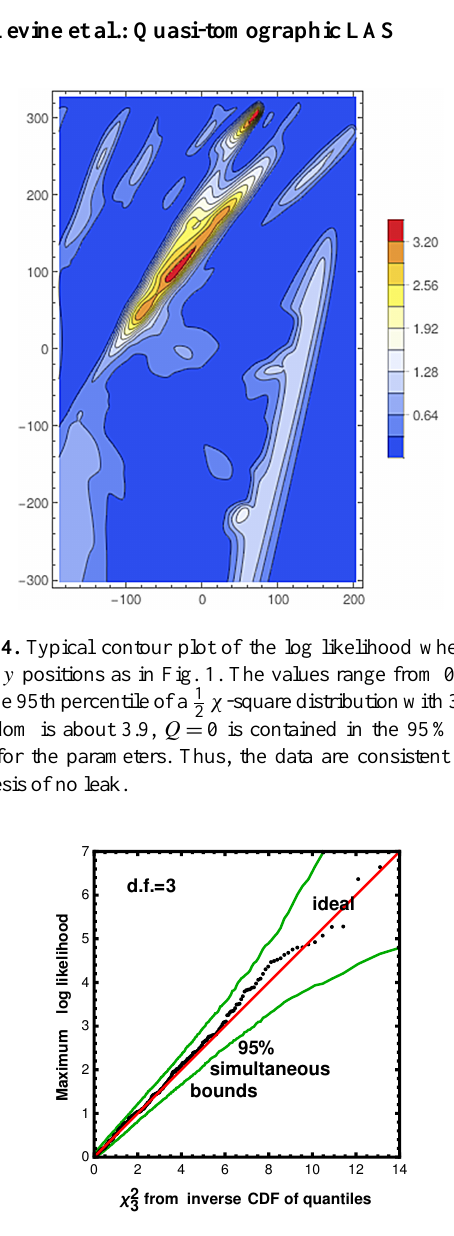
Figure 5. Maximum log-likelihood values were acquired from n = 380 of 389 simulations with a leak rate of Q = 10 5 µmolmol − 1 m 3 s − 1 and a position chosen with uni- form probability from the pale blue ellipse in Fig. 1. CDF refers to the cumulative distribution function. The red line represents or- dered random deviates that align perfectly with their corresponding χ 2 quantiles. If the points wander outside of the bounds given by the green lines, the assumption that the random deviates follow a χ 2 distribution is less tenable.